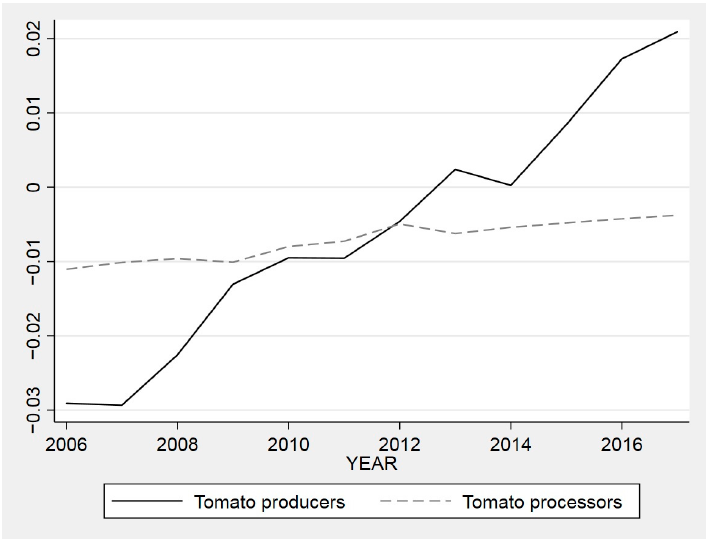
Figure 1. Development of technological change. Source: authors’ calculations.